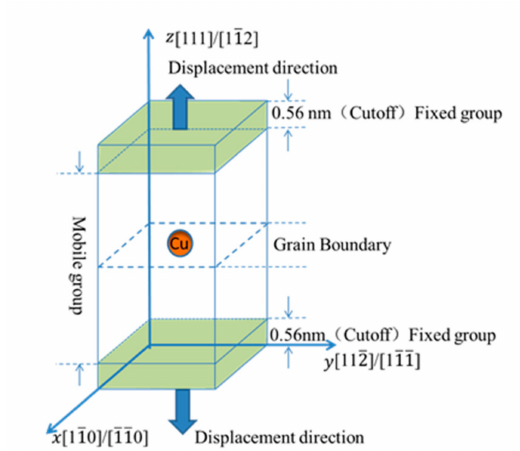
Figure 1. Schematic diagram of tensile simulation